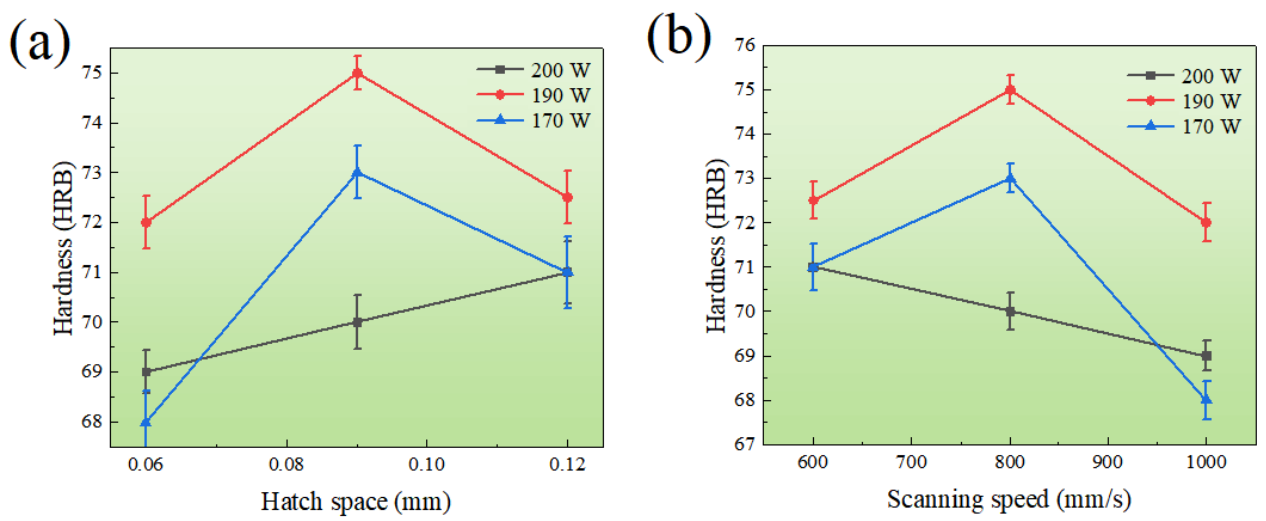
Figure 5. The hardness depended on hatch space ( a ) and scanning speed ( b ) under different heating power levels of 170, 190 and 200 W.